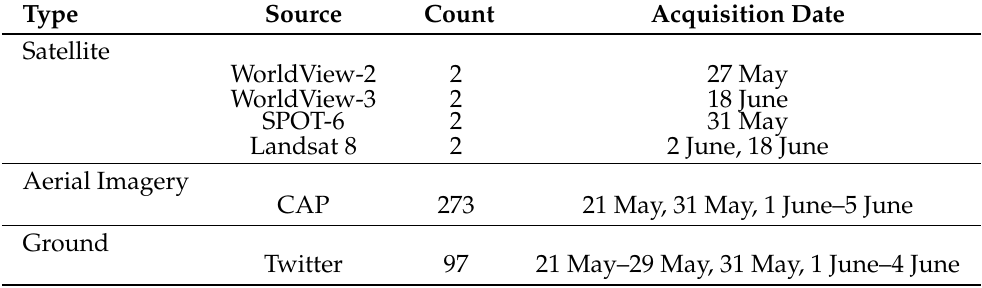
Table 1. Overview of all data sources summarized based on data type, quantity, and day of acquisition. Type